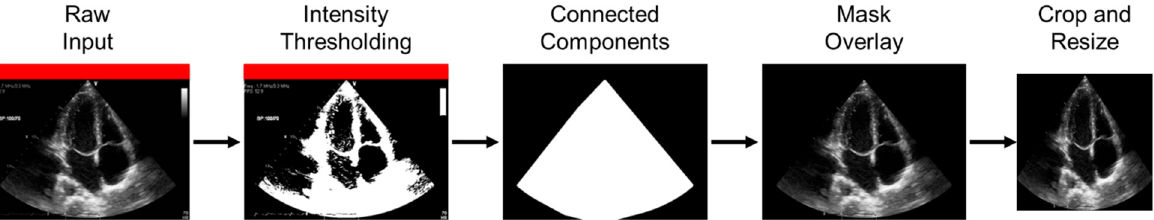
Figure 2. Preprocessing echocardiogram frames. Each image shows the output of the processing, and text above shows the process names. The red bars were used to anonymize the patient information for the figure.